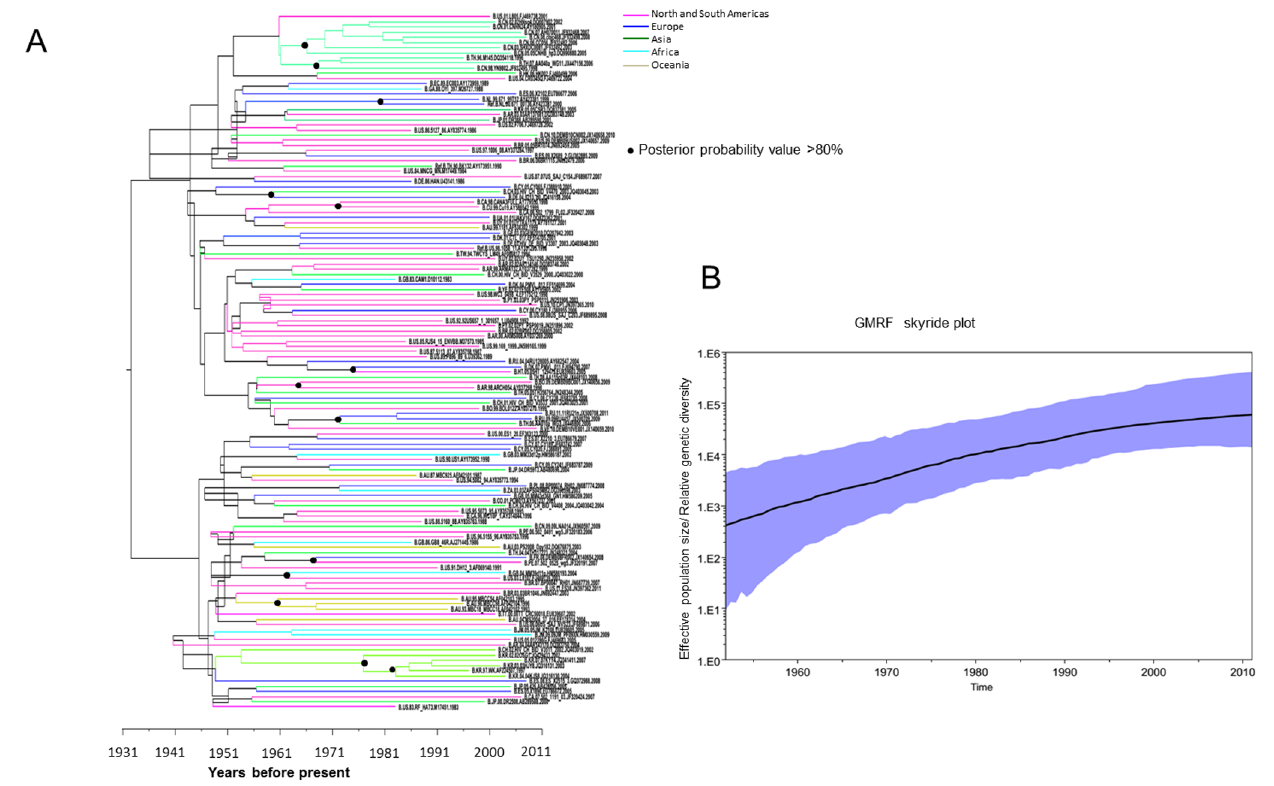
Fig 1. Phylodynamic and Bayesian tree with timescale of HIV-1subtype B Tat sequences from Los Alamos Database. A) Maximum clade credibility tree with time scale obtained from the strict molecular clock. Time to the most recent common ancestors (tMRCA) was indicated in years at the bottom of the figure. B) Gaussian Markov random field (GMRF) skyride plot estimated by strict clock method. The X-axis represents the time in year. The Y-axis represents the HIV-1 Tat effective number of infections (genetic diversity). The black line marks the median estimate for effective population size and the blue shading shows region displays the 95% highest posterior density (HPD)